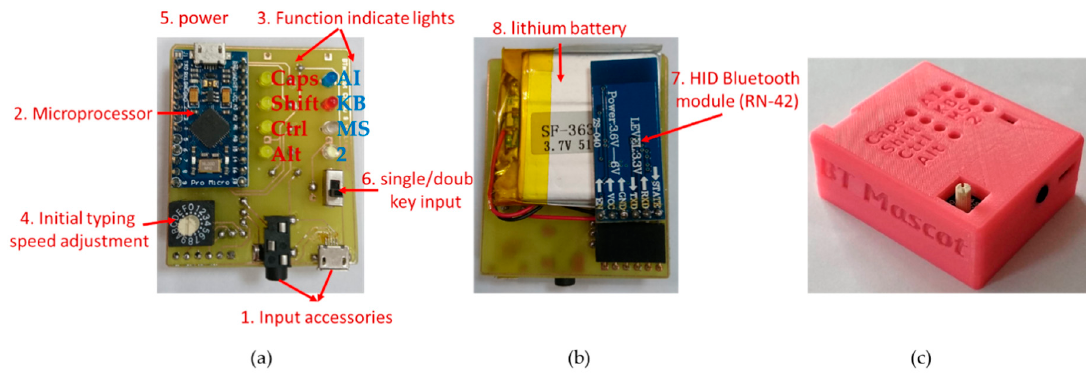
Figure 5. The entity of MCT: ( a ) The front side of the panel, ( b ) The back side of the panel, and ( c ) MCT product.